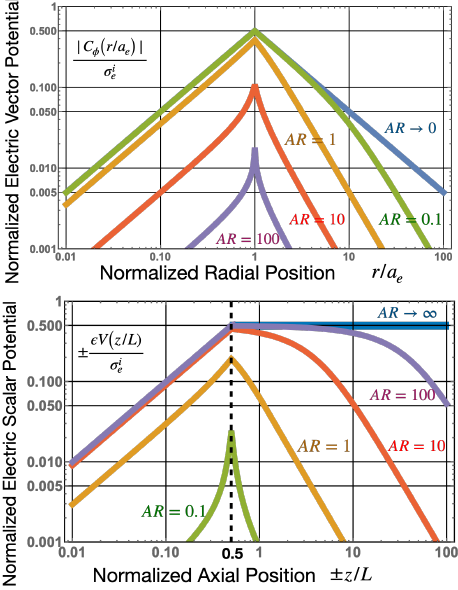
Figure 4. ( Above ): Normalized electric vector potential versus normalized radial distance, (at z = 0 centre of the dipole) for various aspect ratios, compared to the infinitely long dipole ( AR → 0). ( Below ): Normalized electric scalar potential, versus normalized axial position, (at r = 0 centre of the dipole) for various aspect ratios, compared to the infinitely wide dipole AR → ∞ . Here, the length of the dipole is L , where AR = 2 a e , so the end face of the dipole are at z / L = ± 1 . L 2